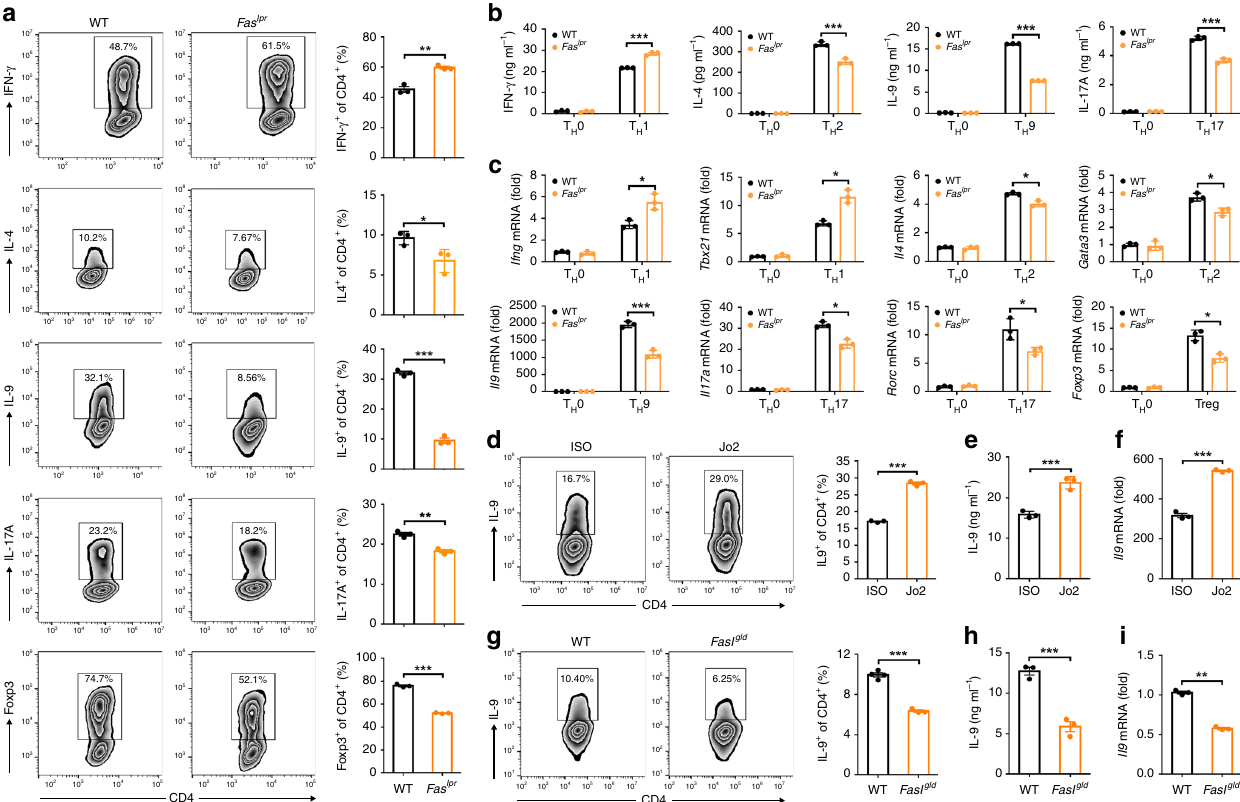
Fig. 1 Fas signaling promotes T helper type 9 (T H 9) cell differentiation in vitro. a – c Naiïve CD4 + CD62L hi CD44 lo T cells were sorted from wild-ype (WT) and Fas lpr mice and differentiated into T H 0, T H 1, T H 2, T H 9, and T H 17 cells and T regulatory cells (Tregs) in the presence of plate-bound anti-CD3 and anti- CD28 for 3 – 4 days. Flow cytometric analysis of the frequencies of IFN- γ + , IL-4 + (interleukin-4 + ), IL-9 + , IL-17A + , and Foxp3 + cells among CD4 + T cells (left) and the corresponding statistical analysis (right) on day 4 ( a ); enzyme-linked immunosorbent assay (ELISA) measurements of the IFN- γ , IL-4, IL-9 and IL-17A levels in supernatants from the T H 0, T H 1, T H 2, T H 9, and T H 17 cells on day 3 ( b ); and real-time PCR analysis of the expression of the indicated genes in the T H 0, T H 1, T H 2, T H 9, and T H 17 cells and Tregs on day 3 ( c ). d – f Naive CD4 + CD62L hi CD44 lo T cells were sorted from WT mice and differentiated into T H 9 cells with 10 μ g ml − 1 isotype control antibodies (ISO) or anti-Fas antibodies (Jo2) for 3 – 4 days. Flow cytometric analysis of the frequency of IL-9 + cells among the CD4 + T cells (left) and the corresponding statistical analysis (right) ( d ), ELISA measurement of the IL-9 cytokine levels in the supernatants of the T H 9 cells ( e ), and real-time PCR analysis of Il9 gene expression in the T H 9 cells ( f ). g – i Naive CD4 + CD62L hi CD44 lo T cells were sorted from WT and Fas gld mice and differentiated into T H 9 cells for 3 – 4 days. Flow cytometric analysis of the frequency of IL-9 + cells among the CD4 + T cells (left) and the corresponding statistical analysis (right) ( g ), ELISA measurement of the IL-9 cytokine levels in the supernatants of the T H 9 cells ( h ), and real-time PCR analysis of Il9 gene expression in the T H 9 cells ( i ). * P < 0.05, ** P < 0.01, and *** P < 0.001 (unpaired Student ’ s t test). Representative results from three independent experiments are shown (mean and s.d.) ( n =